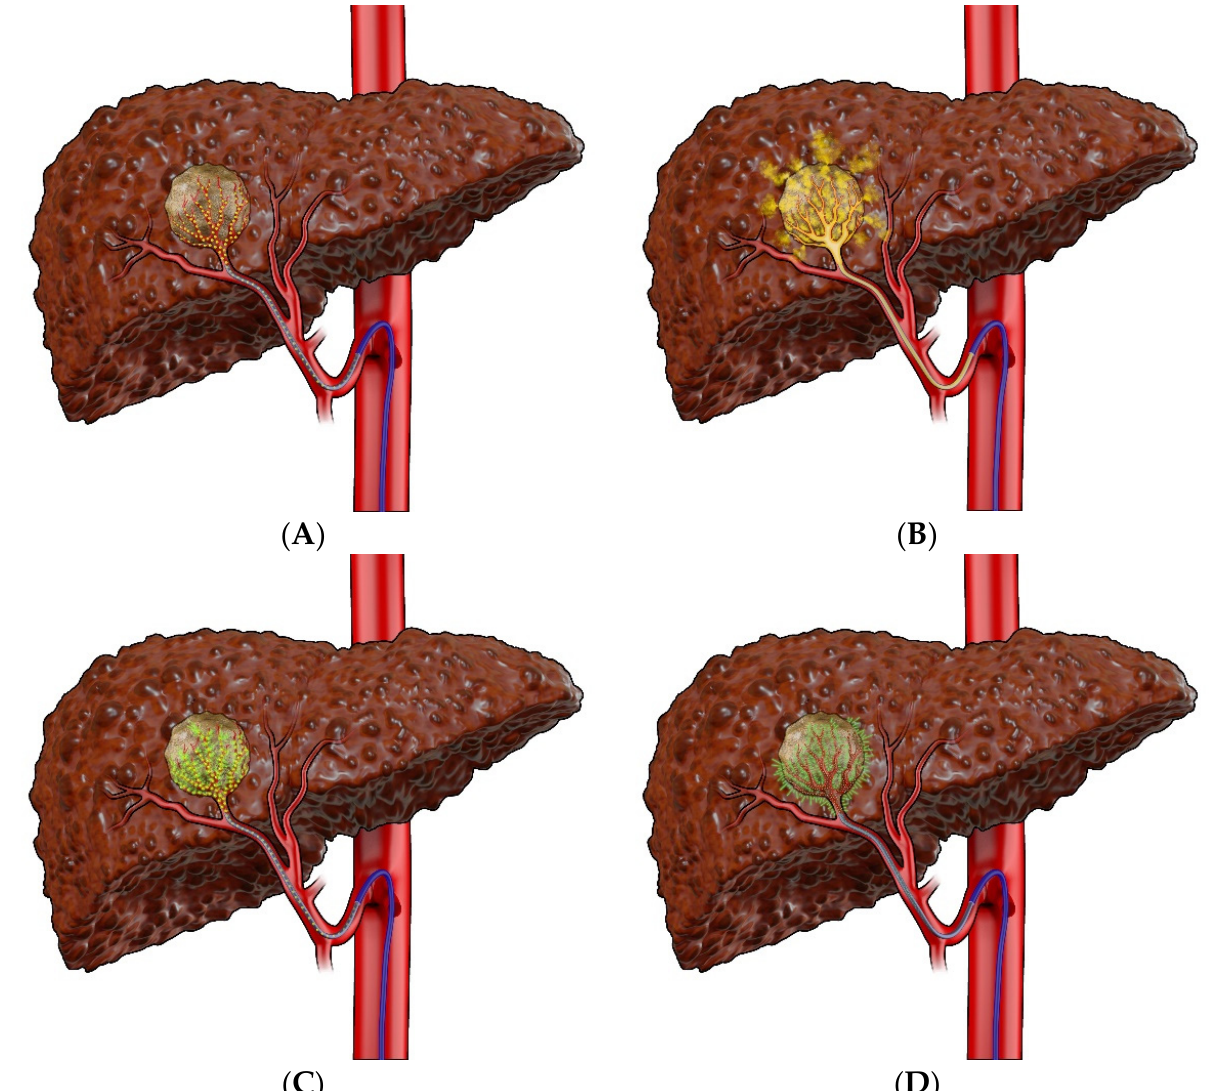
Figure 1. Transarterial therapies. ( A ) Bland embolization (BE). ( B ) Conventional transarterial chemoembolization (cTACE). ( C ) Drug-eluting beads–transarterial chemoembolization (DEBs–TACE). ( D ) Radioembolization.